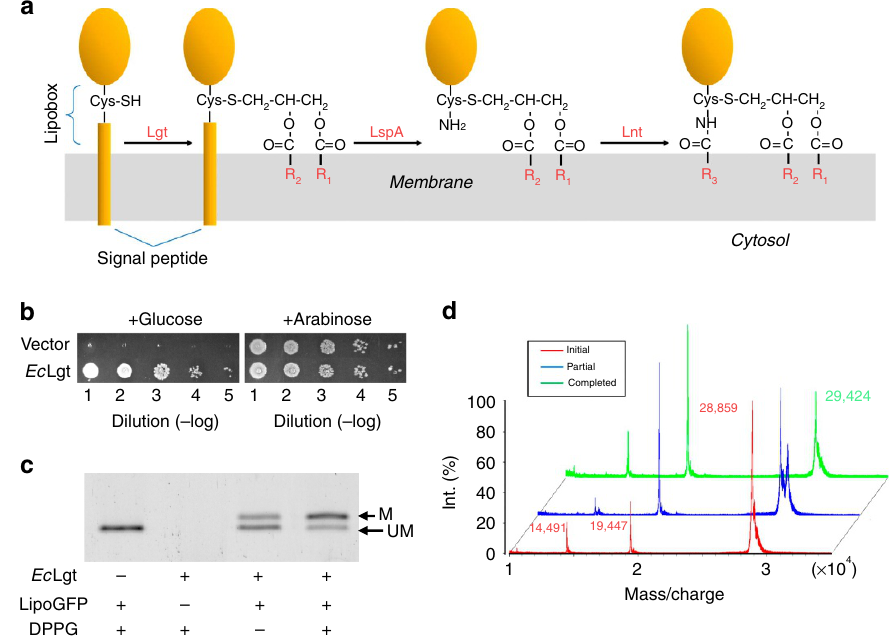
Figure 1 | Functional assays of recombinant WT Lgt. ( a ) Schematic diagram of the three-step peptide lipidation reaction. The third reaction only occurs in Gram-negative bacteria. ( b ) Complementation assay of Lgt with the D lgt cell strain. A serial dilution of cell culture was spotted onto solid medium containing either 11mM glucose (left columns) or 1mM arabinose (right columns). Images were taken 16h after incubation at 37 (cid:2) C. ( c ) In vitro transacylation assay. Ec Lgt (1.2 m M) was incubated with lipoGFP (peptide substrate, 7 m M) in the presence or absence of DPPG (donor substrate, 40 m M). An amount of 25 ng of lipoGFP from each reaction was loaded onto the SDS gel. The lower band (UM) is the unmodified lipoGFP (acceptor substrate) and upper band (M) is the lipid-modified lipoGFP (product). Activity in the absence of externally added PG is attributed to the presence of PG associated with Lgt in the purified preparation. Uncropped images are shown in Supplementary Fig. 6. ( d ) MALDI-TOF Mass spectroscopy analysis of the in vitro reaction mixtures. During the reaction, the lipoGFP peak moved from 28,859Da (red peak) to 29,424Da (green peak), with their mass difference matching well with the calculated value of